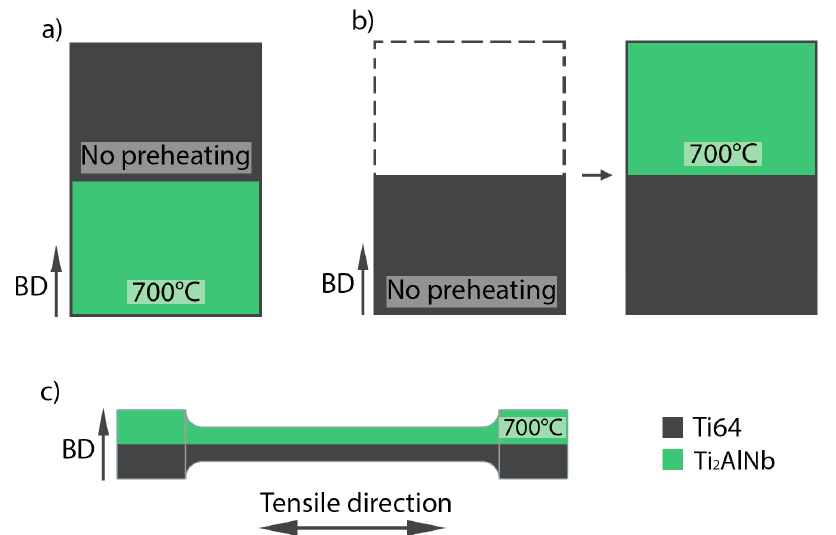
Figure 1. Scanning electron microscope (SEM) images of ( a ) Ti2AlNb and ( b ) Ti64 powders.